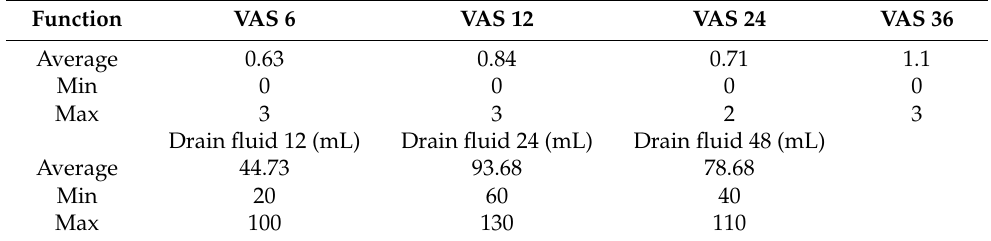
Table 4. An analysis of the VAS dynamics and amount of drain fluid for Group A.